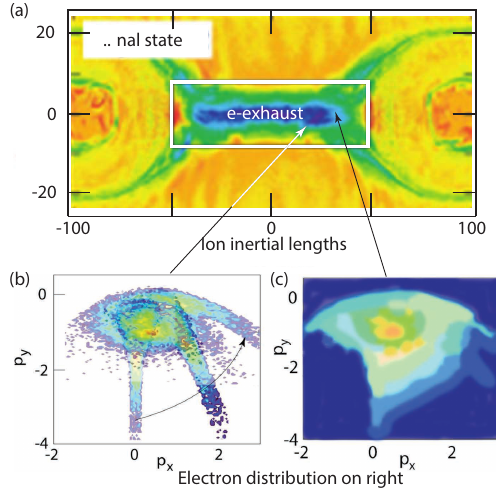
Figure 5. Simulation of particle density (a) in 2-D non-guide field reconnection (after Bessho et al., 2014). The about rectangular shape of the electron exhaust is recognized as the green domain with nearly no electrons in its centre. In this non-guide field sim- ulation the length of the exhaust extends to roughly 50 λ i on both sides of X. More interesting is the evolution of the electron distri- bution function (b, c) . The left panel is a superposition of snapshots of distribution functions at increasing distance to the left from the X point. The distribution gradually evolves into the average distri- bution shown on the right and exhibits a strong anisotropy in mo- mentum space. The light green ring with its yellow maximum shows the perpendicular anisotropy forming a well-expressed ring struc- ture (the quantitative colour scale is suppressed). In the presence of a guide field the distribution forms a ring perpendicular to the guide field. Without guide field such distributions excite the Weibel instability (Weibel, 1959; Fried, 1959; Yoon and Davidson, 1987; Treumann and Baumjohann, 2012, 2014) and create a secondary magnetic field which structures the current and leads to magnetic turbulence. In the presence of a guide field Weibel instability is sup- pressed while the anisotropy favours the